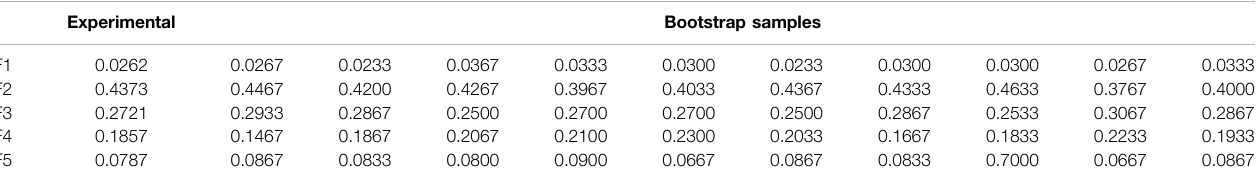
TABLE 2 | Experimental proportions and fi rst ten bootstrap realisations of